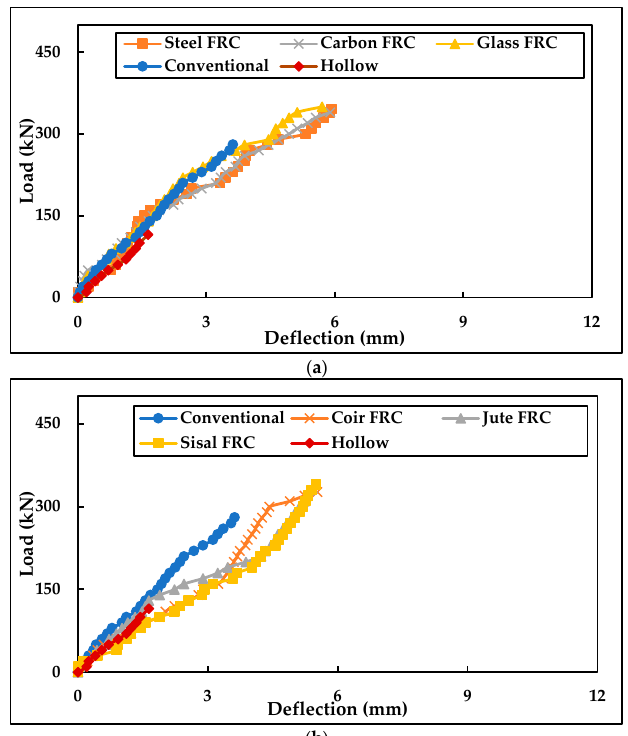
Figure 6. Graphical illustration of load vs. deflection of medium columns. ( a ) Artificial FRC. ( b ) Natural FRC.